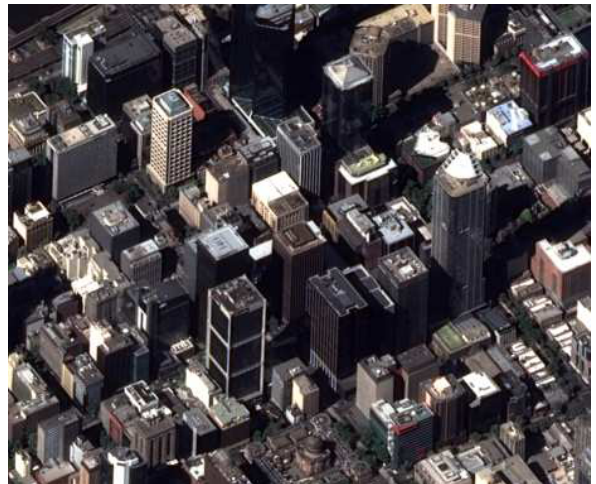
Figure 1 : Pleiades-HR image of Melbourne downtown,